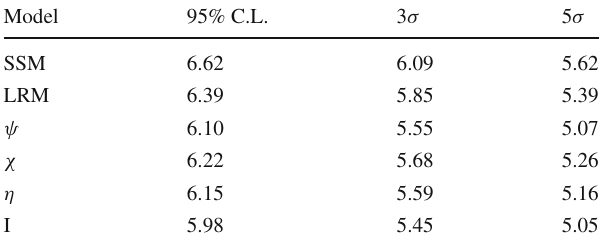
Fig. 11 Left: σ B l in the NWA for the Z (cid:2) production at the (magenta), η (cyan), I(yellow). (Right) σ B l of Z (cid:2) in models described in (left) at Table 7 Mass reach for several Z (cid:2) models at 3 ab − 1 Model 95%